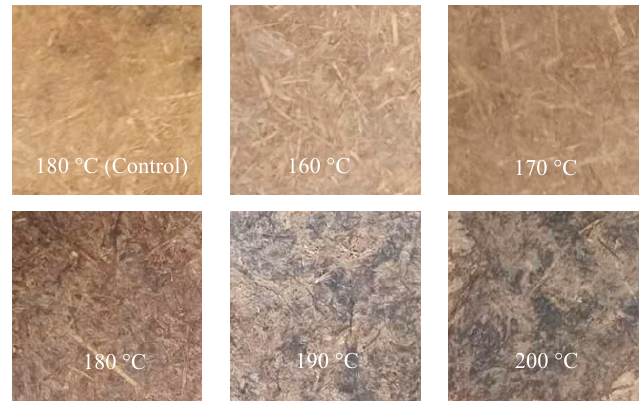
Figure 1. Photographs of fiberboards produced at different temperatures.